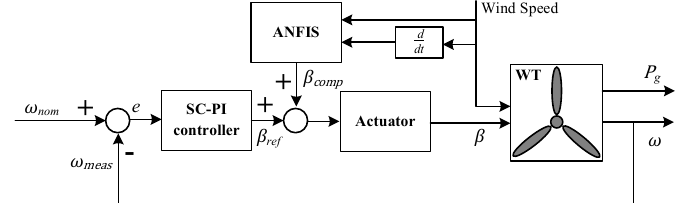
Fig. 2. Proposed pitch angle control system.